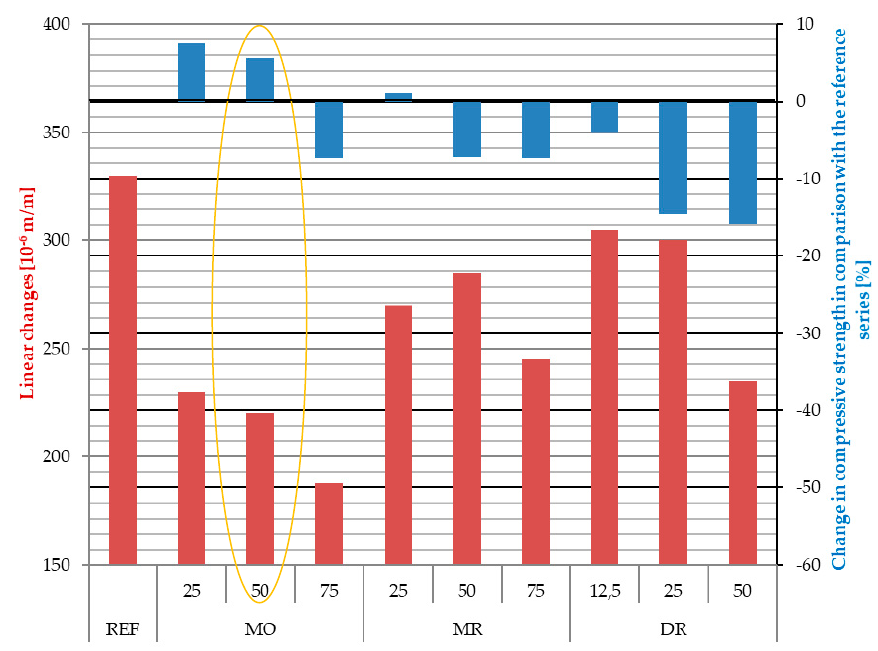
Figure 12. Changes in the compressive strength of superabsorbent polymers (SAP) modified series in comparison with the reference series and the effect on linear changes caused by shrinkage deformations. The optimal composition is marked with the ellipse.